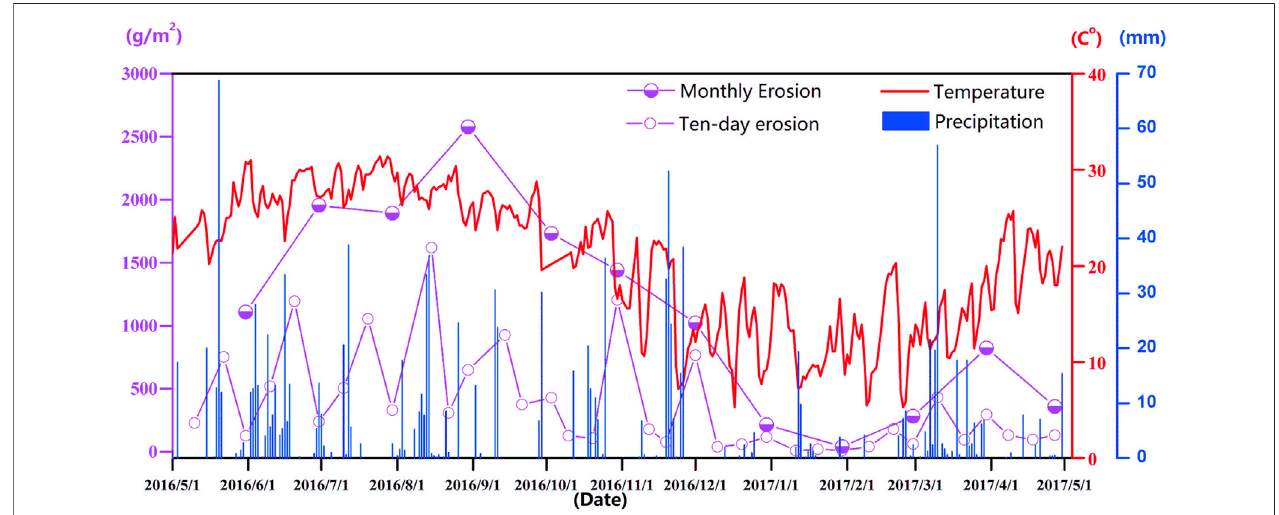
FIGURE 4 | Erosion amount and the environmental variables during the study period.